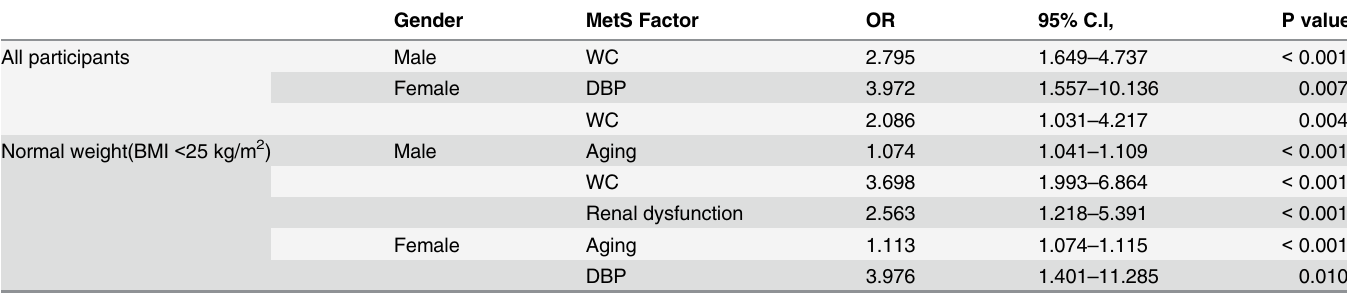
Table 4. Multivariate analysis of MetS risk factors and LVMR.